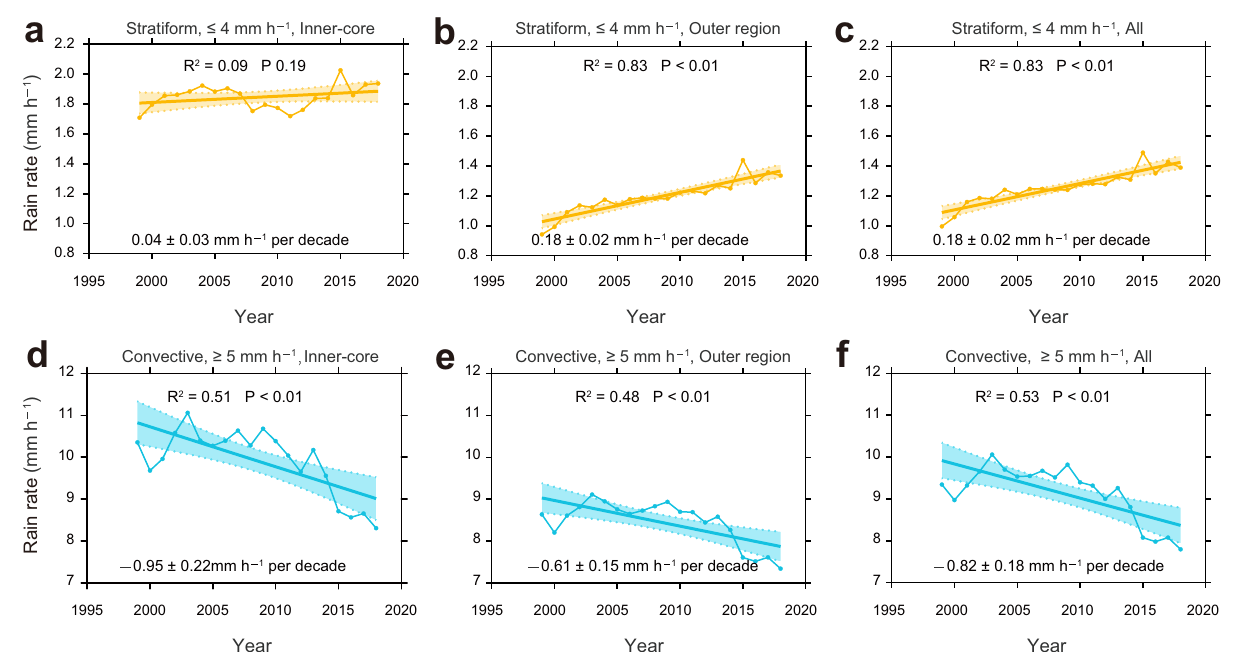
Fig. 4 Time series of stratiform and convective rain rate of tropical cyclone (TC). a – c Stratiform rain rate, d – f convective rain rate, unit: mm h − 1 . a , d Inner-core of TC. b , e Outer region of TC. c , f Combined inner-core and outer region of TC. The shading area in all panels indicate the two-sided 95% con fi dence levels of the trends, and the bold lines represent the linear regression. All of the linear trends expect a are signi fi cant at 95% con fi dence level. Time series are constructed from the Tropical Rainfall Measuring Mission (TRMM) Multi-Satellite Precipitation Analysis (TMPA) dataset.